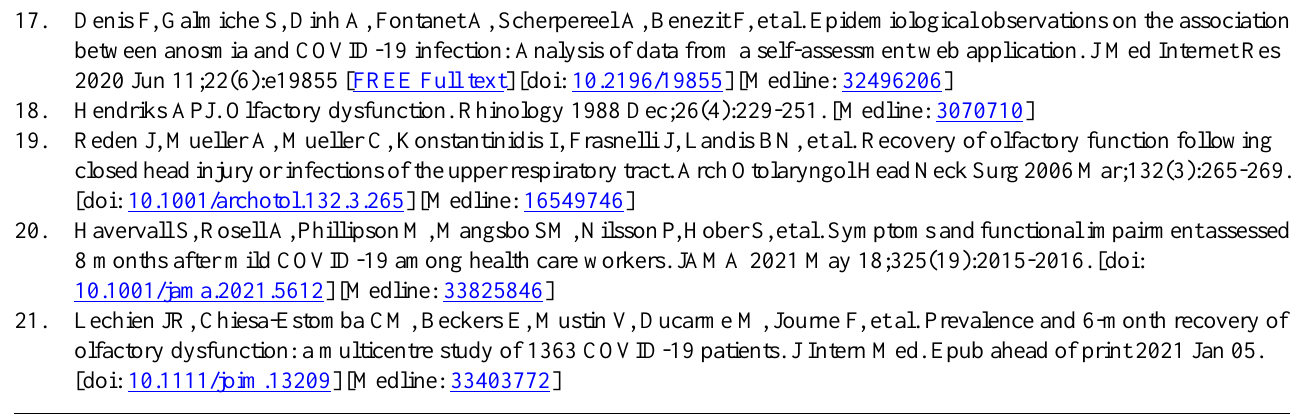
Abbreviations SAS: Statistical Analysis